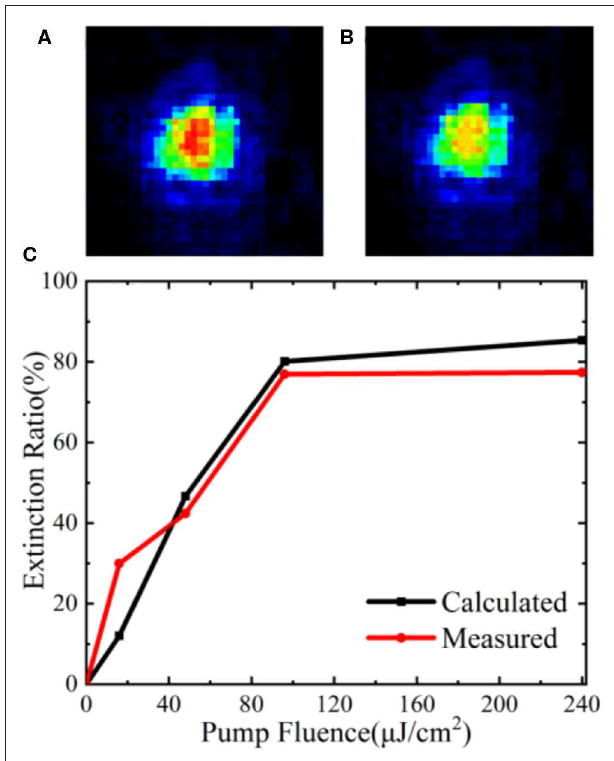
FIGURE 7 | Terahertz intensity distributions through the CsPbBr 3 -QD-embedded metasurface. (A) 0 µ J/cm 2 and (B) 240 µ J/cm 2 pump laser intensity. (C) Extinction ratio dependence of pump laser intensity.